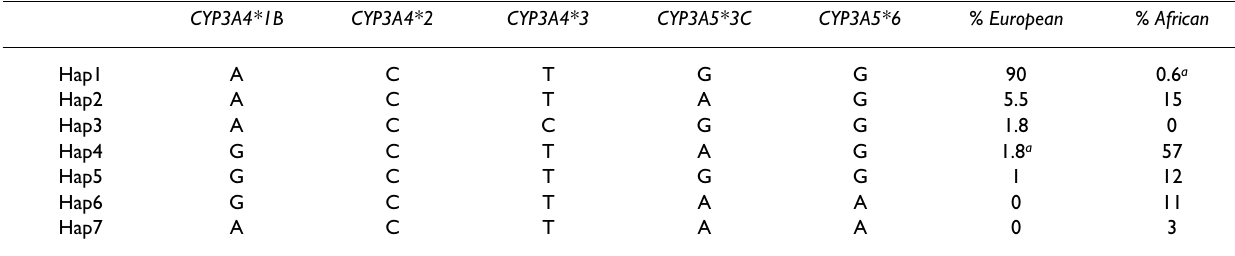
Table 3: Haplotype analyses for CYP3A4 and CYP3A5